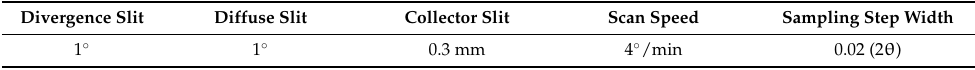
Figure 14. Effect of feed rate on diffraction peak of metamorphic layer. 3.2.2. Observation of Metallographic Morphology Figure 15A,B are respectively the metallographic morphology of the machined met- amorphic layer with the feed rate of 0.1 mm/r and 0.2 mm/r at the cutting speed of 260 m/min. It shows that the substrate material of the machined section comprises ferrite and pearlite. During the machining process, high temperature and strain are produced in the cutting area, which causes some ferrite and pearlite to transform into austenite. Under XRD diffraction, grain refinement can be observed. It shows that there is a metamorphic layer in the machined section, which leads to work hardening of the machined section and affects the machined surface quality.